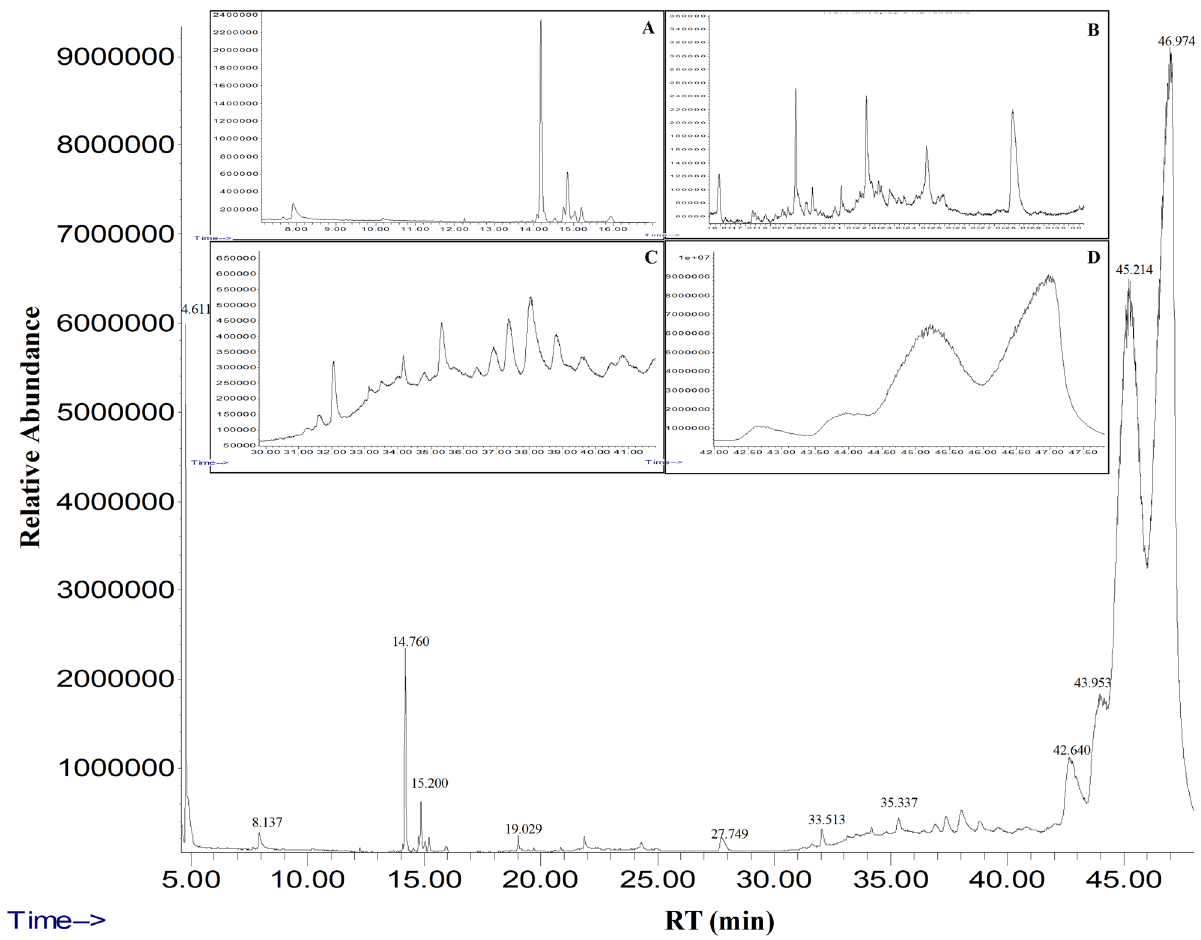
Figure 1. Gas chromatography and mass spectrometry chromatogram of fig latex analysis. The analysis demonstrated several peaks with different retention times to 47 min of twenty-four active constituents. A, B, C and D are zoomed regions of the chromatogram, RT, retention